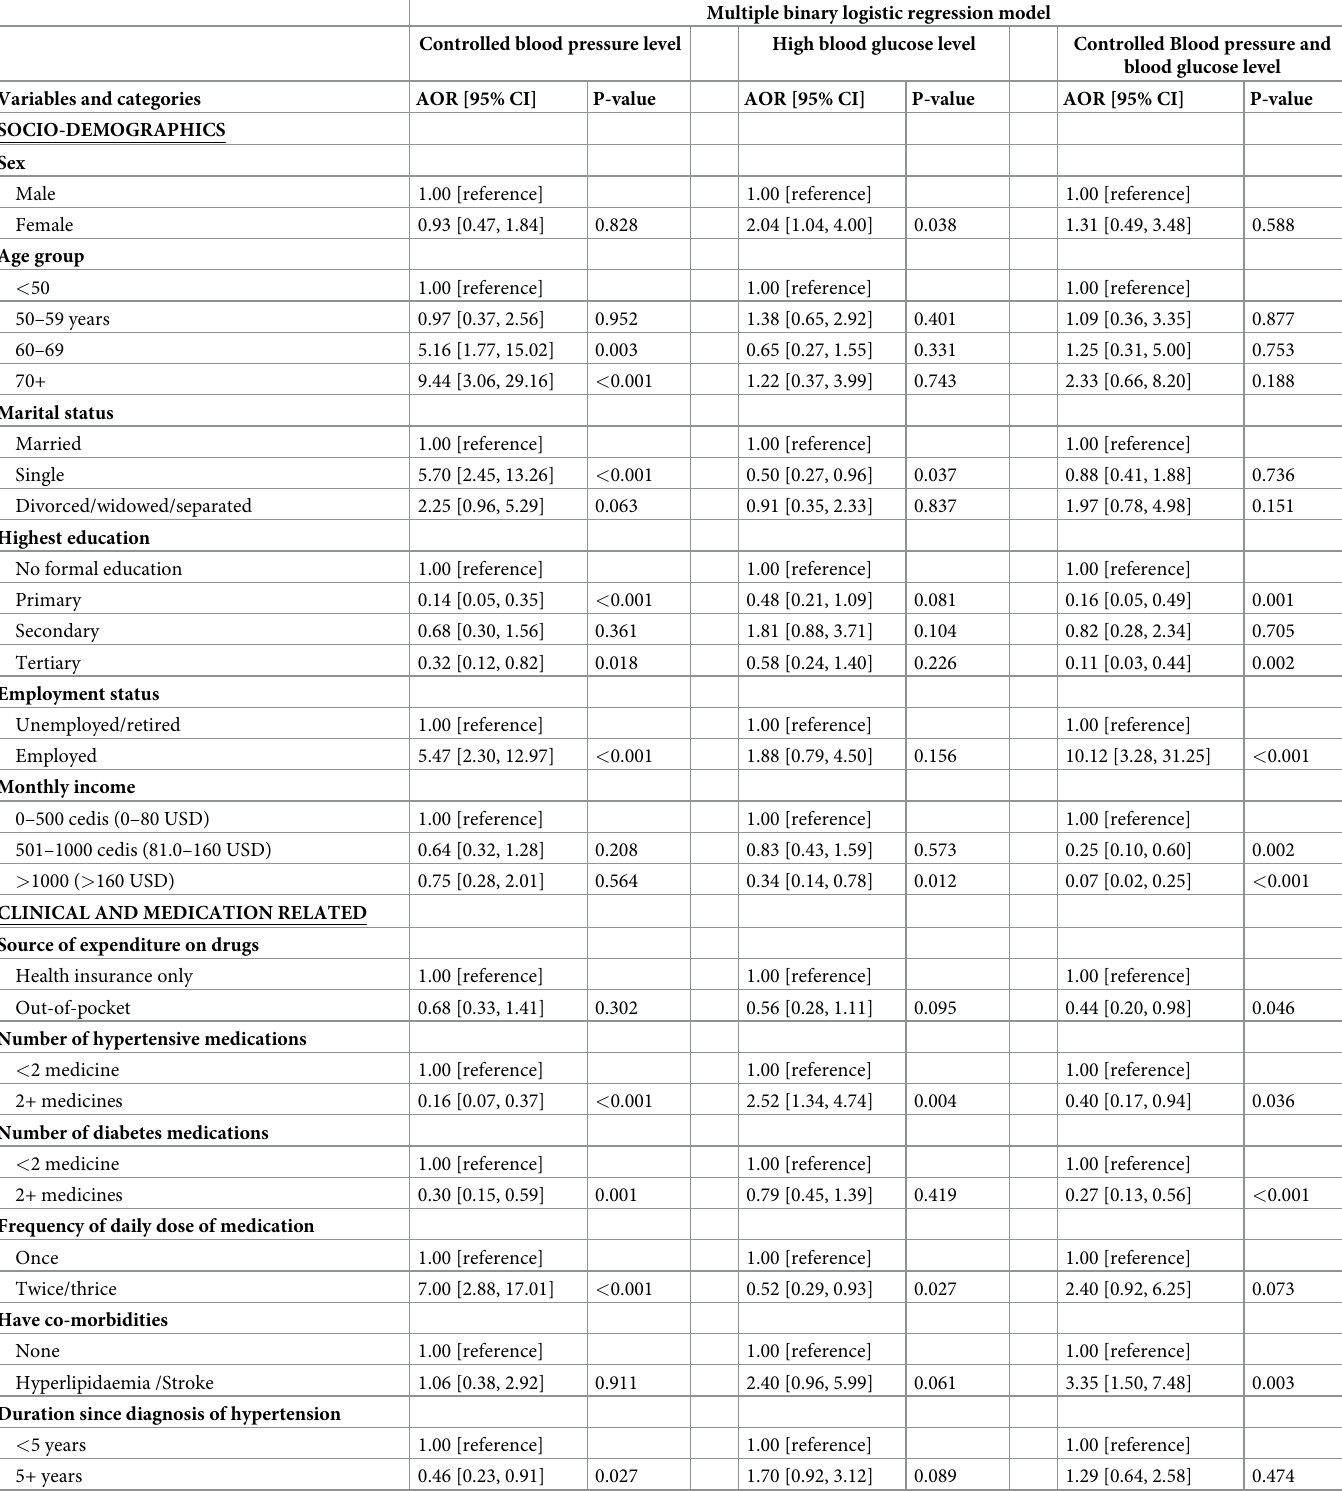
Table 4. Multivariable binary logistic regression model of factors associated with controlled levels of blood pressure, glucose and both blood pressure and glucose among hypertensive and type 2 diabetes mellitus co-morbid